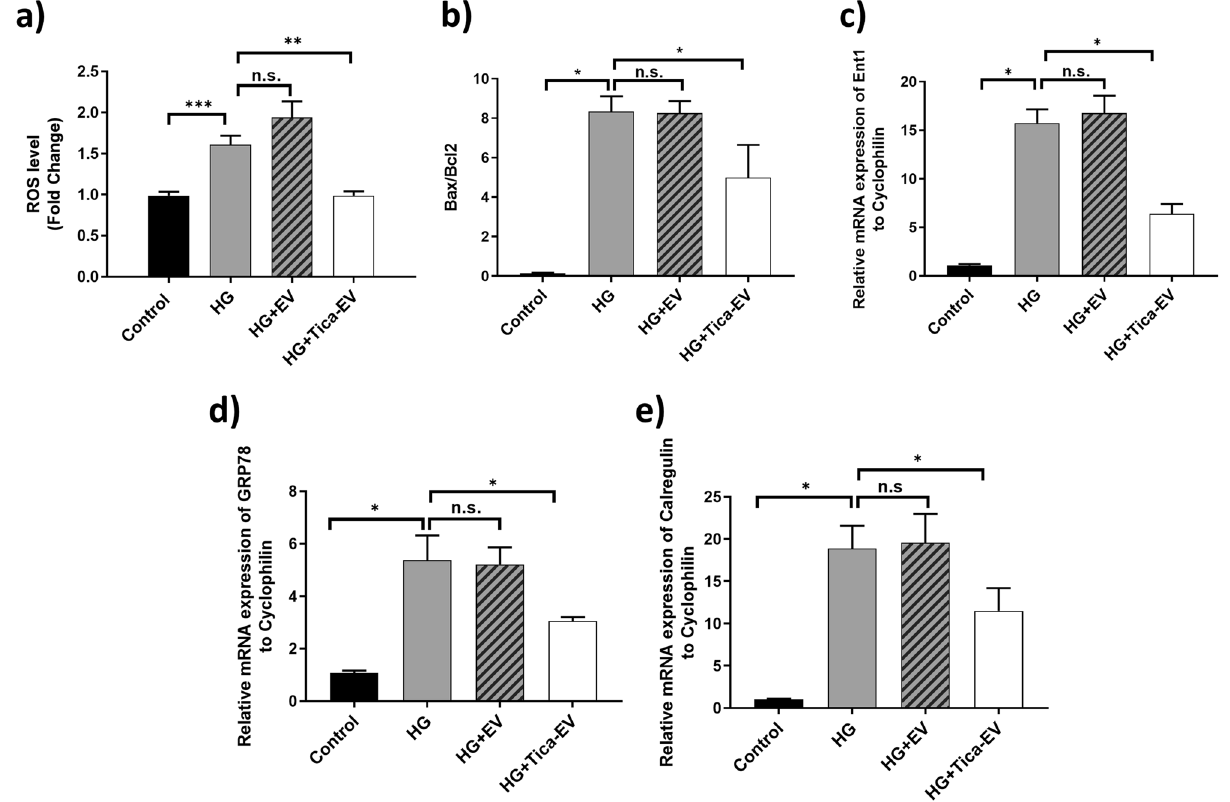
Figure 4. Effects of ticagrelor (Tica, 1-µM) pretreatment of oxidative stress and apoptosis markers. ( a ) The level of ROS production at the cellular level is measured in H9c2 cardiomyocytes. Ticagrelor-pretreated EVs cause a significant decrease in the enhanced ROS production level in HG cardiomyocytes. ( b ) The mRNA expression of Bax and Bcl2 genes are analyzed by qRT-PCR. Bax/ Bcl2 ratio and ( c ) ENT1 is induced upon ticagrelor- pretreated H9c2 EV incubation in HG-incubated H9C2 cells. Ticagrelor-pretreated H9c2 EV treatment reverses the highly increased level of two molecular chaperones: ( d ) GRP78 and ( e ) Calregulin mRNA expressions in HG-H9c2 cells. Data are expressed as the mean ± SD (n = 4). *p < 0.05, **p < 0.01, n.s.: not